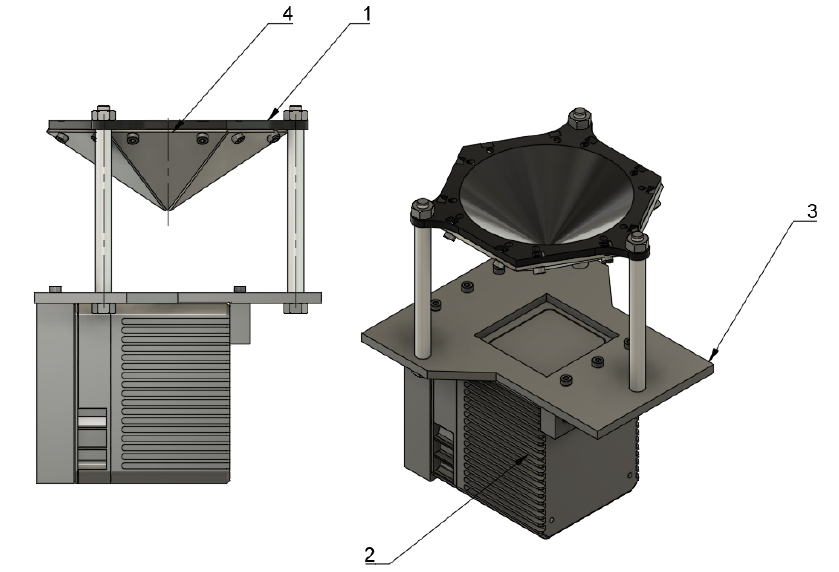
Figure 4. Three-dimensional CAD model of assembly. 1—hexagonal pyramid; 2—Livox LiDAR; 3—face plate; 4—one of six